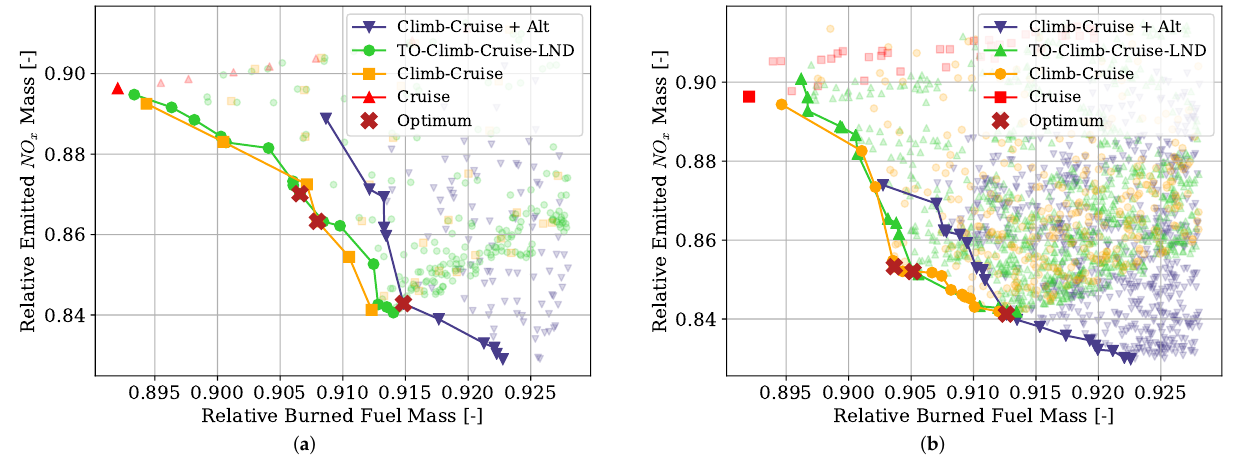
Figure 12. Effects of mission hybridisation: ( a ) Pareto fronts of uniform strategies with different hy- bridised mission phases; ( b ) Pareto fronts of linear strategies with different hybridised mission phases.